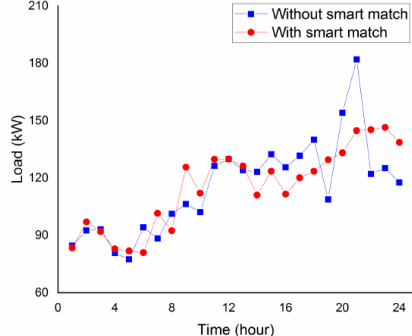
Figure 6. Comparison of load curve.